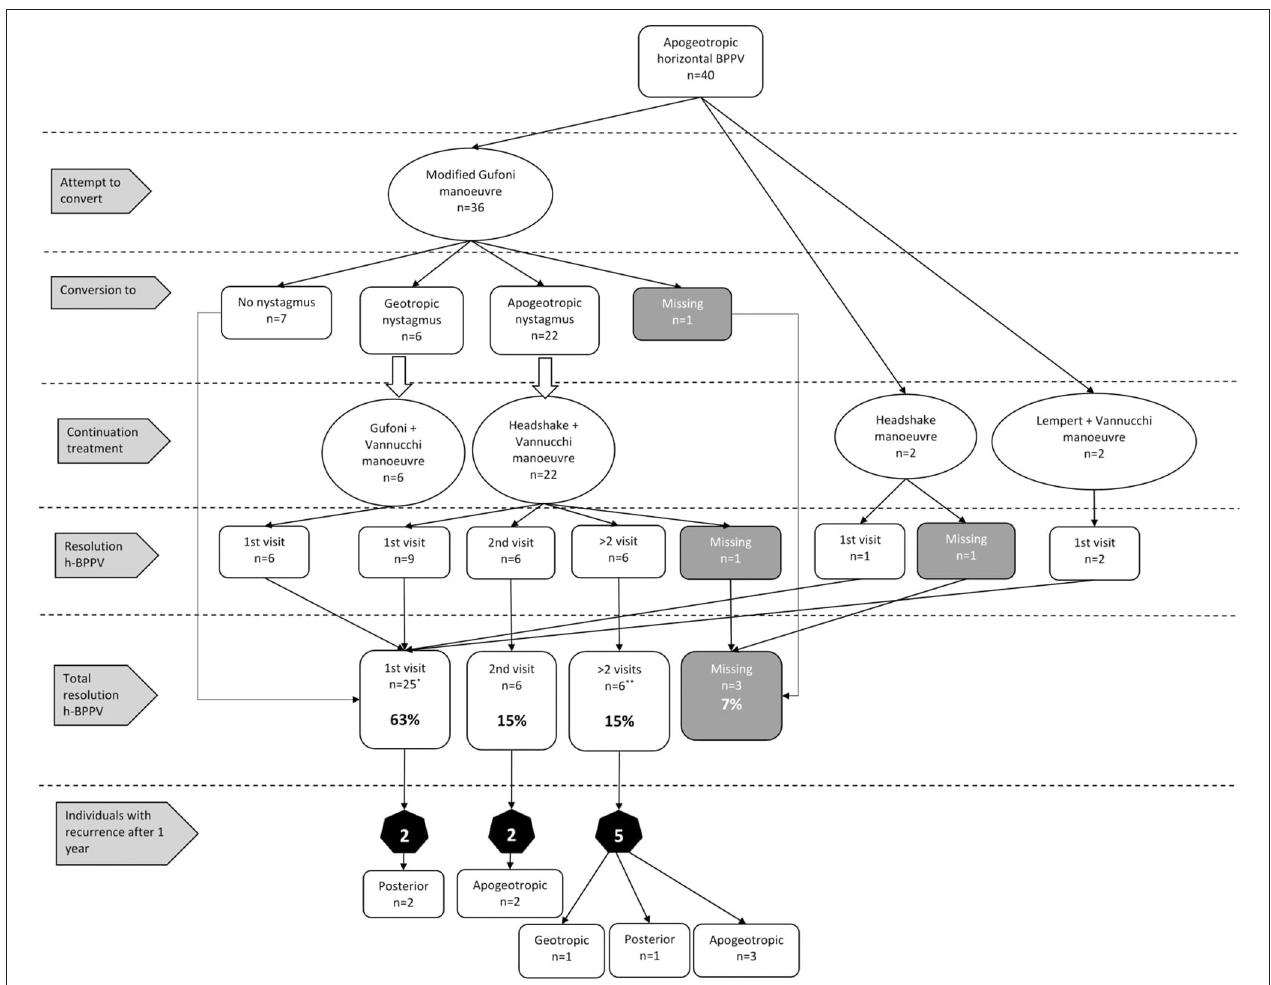
FIGURE 2 | Results of our treatment protocol and the number of recurrences for apogeotropic h-BPPV. (*) 5 patients received additional treatment for posterior canal BPPV. (**) 1 patient received additional treatment for posterior canal